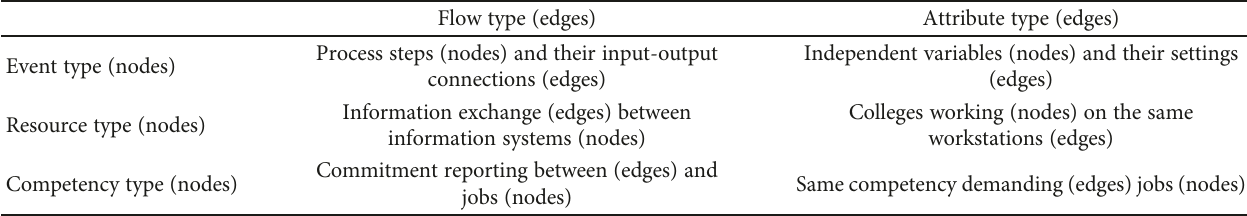
Table 4: Node edge matchings in the proposed network.